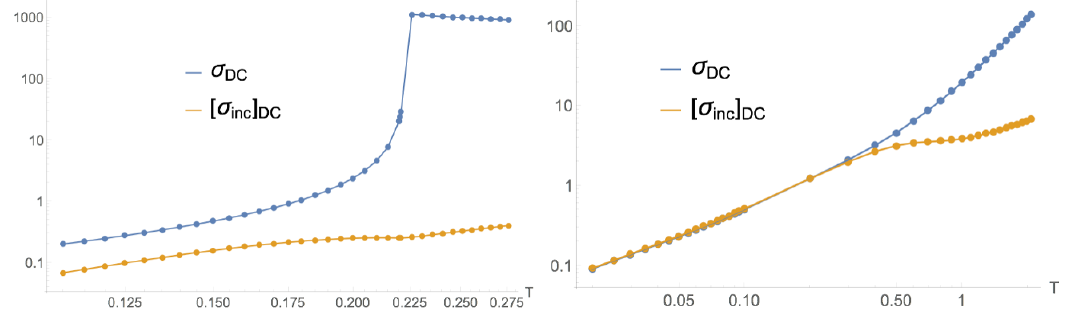
Figure 3 . Optical (blue) and incoherent (yellow) DC conductivities as a function of temperature for pinned spontaneous (left) and explicit (right) holographic insulators. For the pinned spontaneous case we take the thermodynamically preferred purely spontaneous solutions and place them on a lattice with (cid:21) = 0 : 1 (cid:22) (2.11). In the explicit case we take (cid:21) = 3 (cid:22) , k=(cid:22) = 1 (2.8). Both plots are shown in log-log scale. It is apparent that unlike in the explicit case, in the spontaneous case the incoherent conductivity only brings subleading